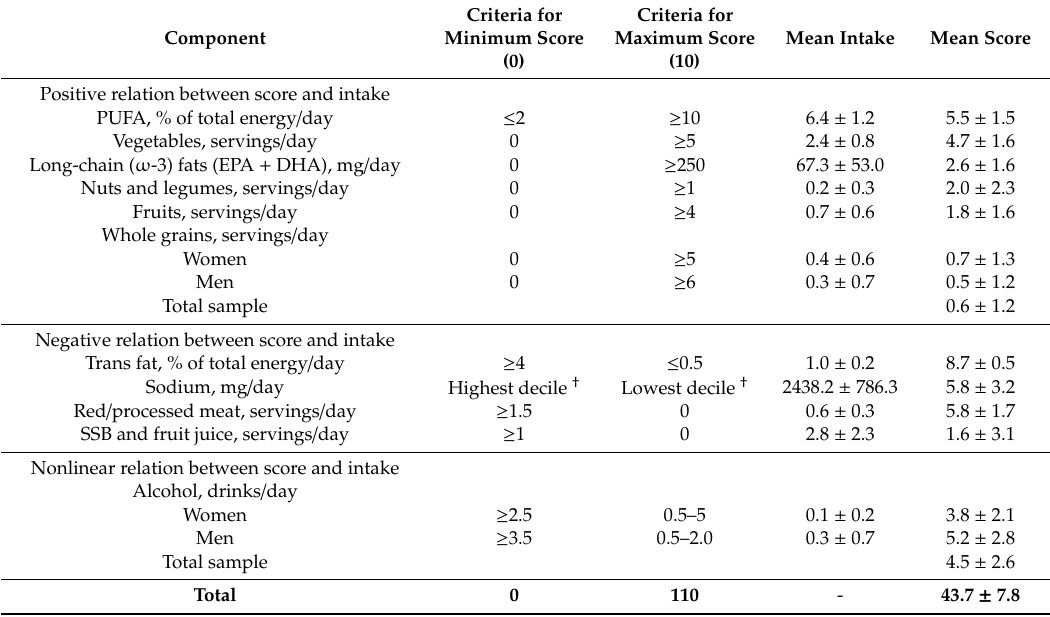
Table 2. Scoring method and mean intakes and scores of each Alternate Healthy Eating Index 2010 component in Chilean urban population enrolled in ELANS